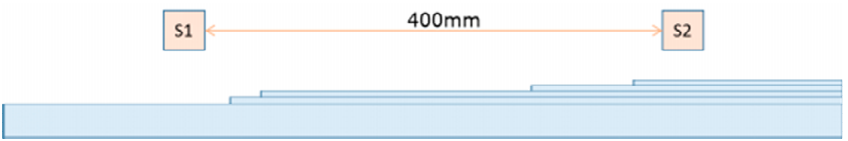
Figure 5. Schematic of a plydrop specimen with the linear AE sensor array (static test).